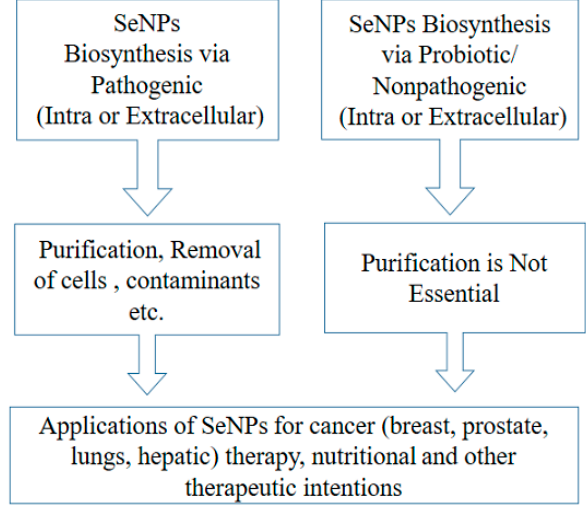
Figure 1. Process handling of biogenic SeNPs and their application as anticancer agents.